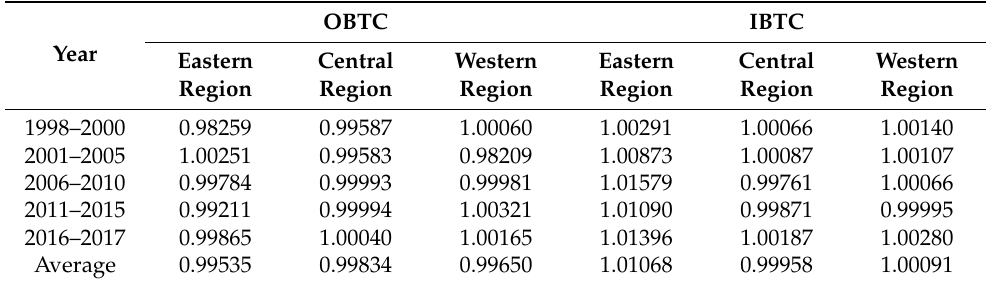
Table 4. Measurement results of BTC index decomposition of each region.